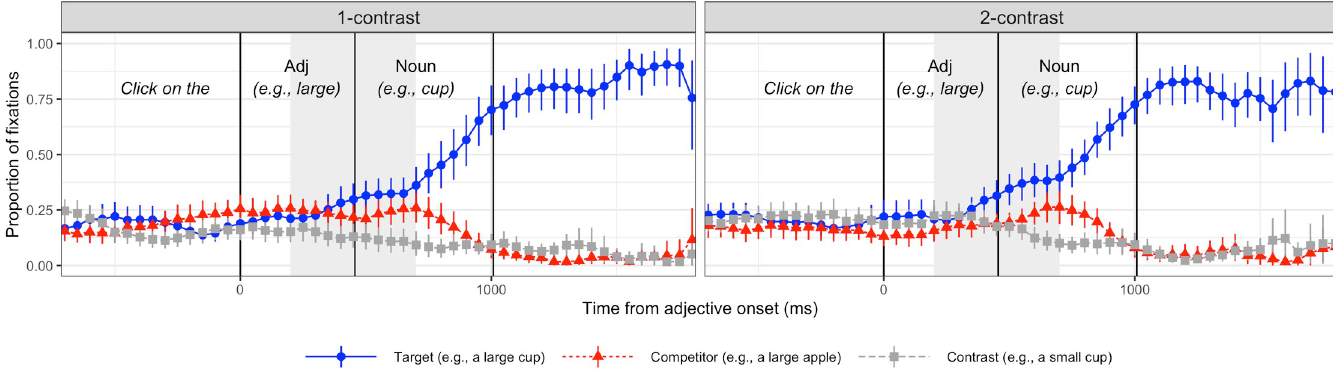
Fig 4. Average proportions of target fixations during the 500ms window starting 200ms after the adjective onset (e.g., Click on the large cup ) by reliability and contrast conditions in Experiments 1 and 2. Error bars represent 95% bootstrapped confidence intervals over those by-participant means.